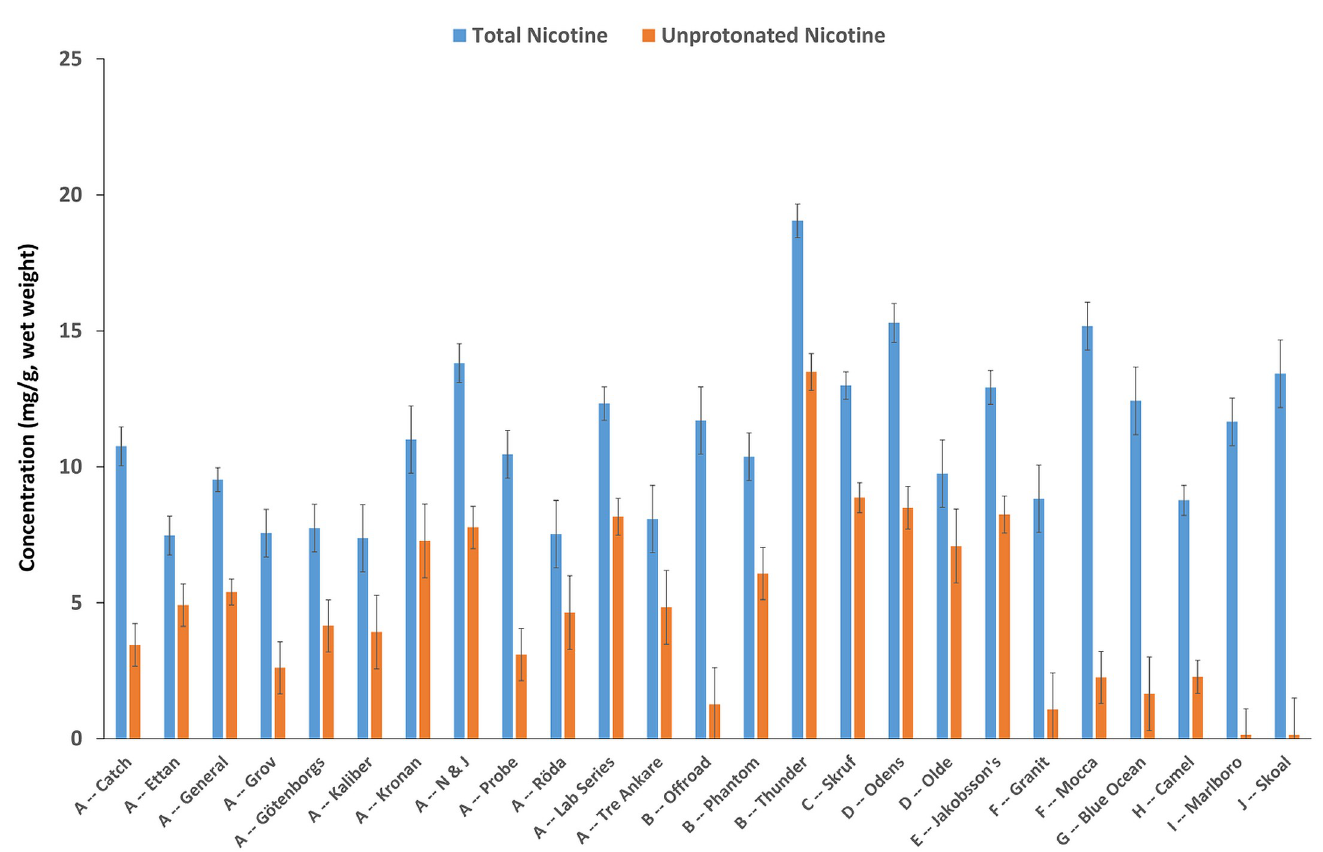
Fig 2. Arithmetic means of total and unprotonated nicotine found in twenty-five snus brand families made by ten manufacturers in Europe [A-G] and the US [H-J]) varied widely among all products. However, US snus had lower unprotonated nicotine compared to NE snus. All levels shown are expressed as milligrams per gram (mg/g) wet weight of product. Note. A-J represent the different manufacturers: A) Swedish Match, B) V2 Tobacco, C) Imperial Tobacco Group, D) GN Tobacco Sweden AB, E) Gotland Snus AB, F) British American Tobacco, G) AG Snus, H) RJ Reynolds, I) Philip Morris, and J) U.S. Tobacco Company. Arithmetic means and standard errors are estimates from 10,000 bootstrap resamples of the data. Error bars represent bootstrapped standard